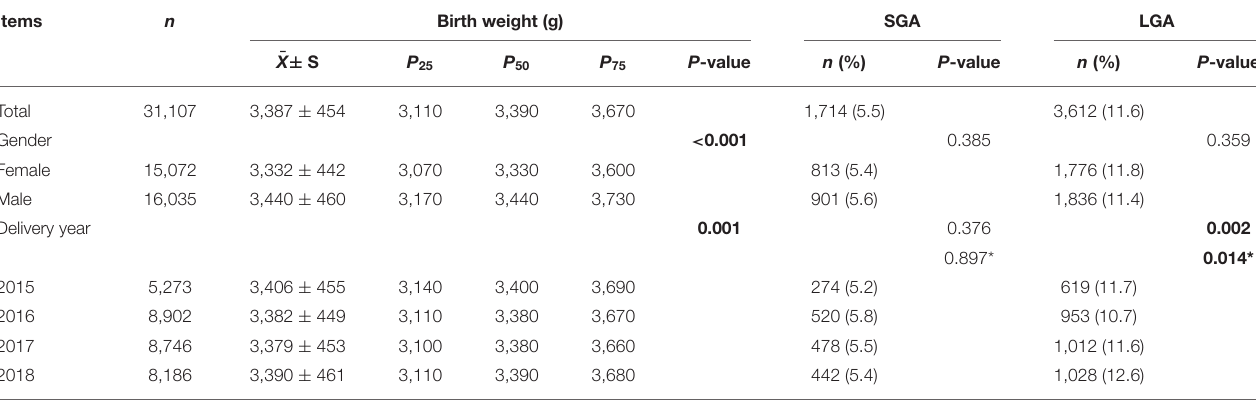
TABLE 3 | Birth weight and prevalence of SGA or LGA among newborns by genders and delivery years. Items